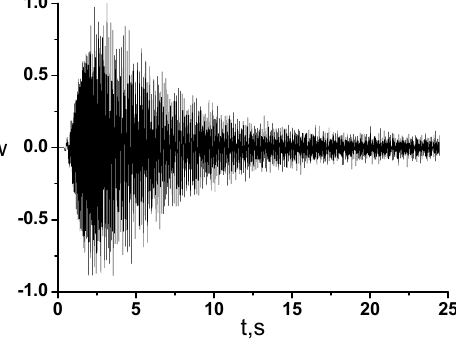
Figure 5. The scaling factor is equal to 1.